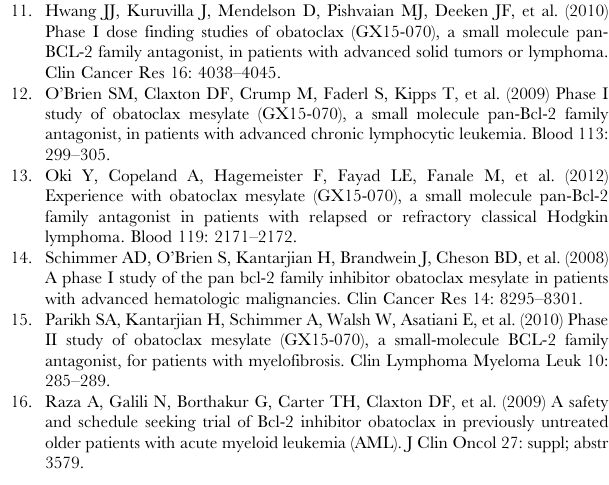
Protocol S1 Study protocol for open-label phase